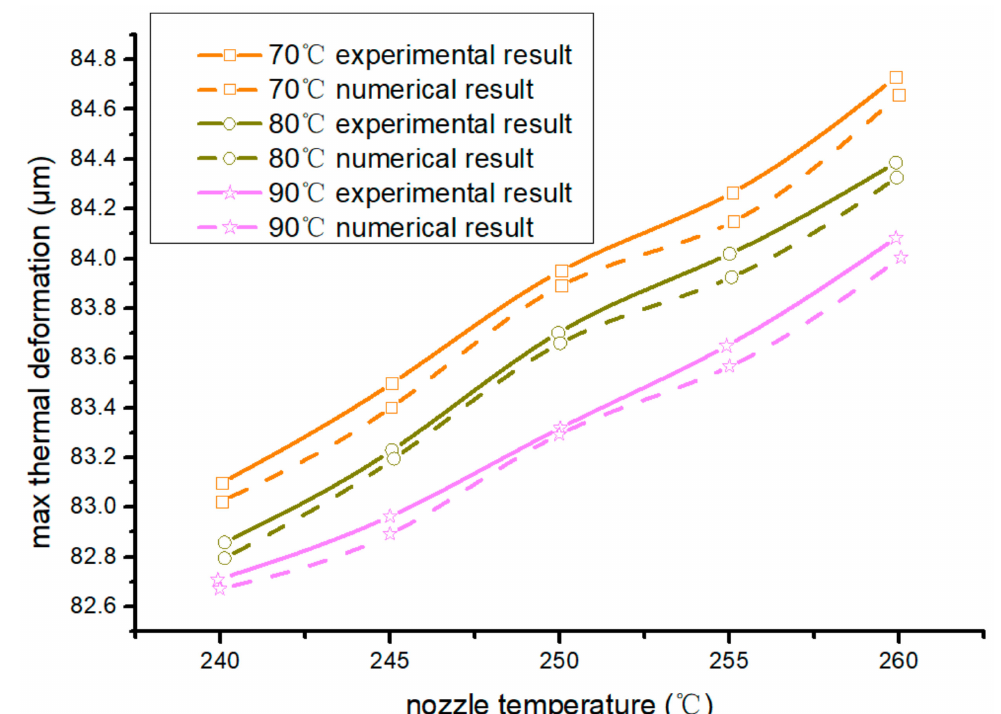
Figure 6. Maximal workpiece thermal-deformation displacement at di ff erent hot-bed